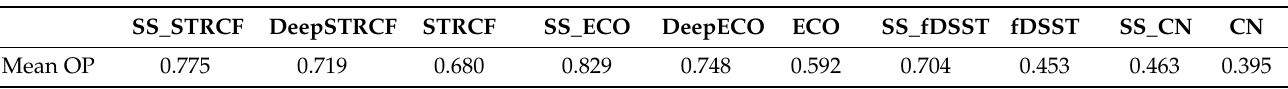
Table 1. Mean overlap precision (OP) metric (in %) and fps of our SSCF and their corresponding baseline